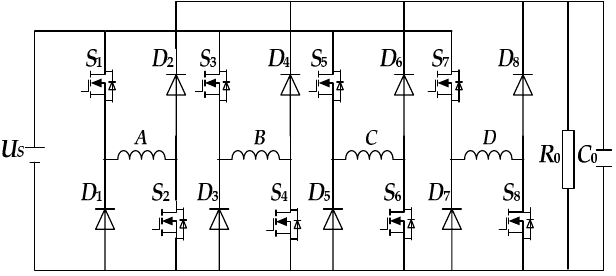
Figure 2. The main circuit structure diagram of separate excitation.